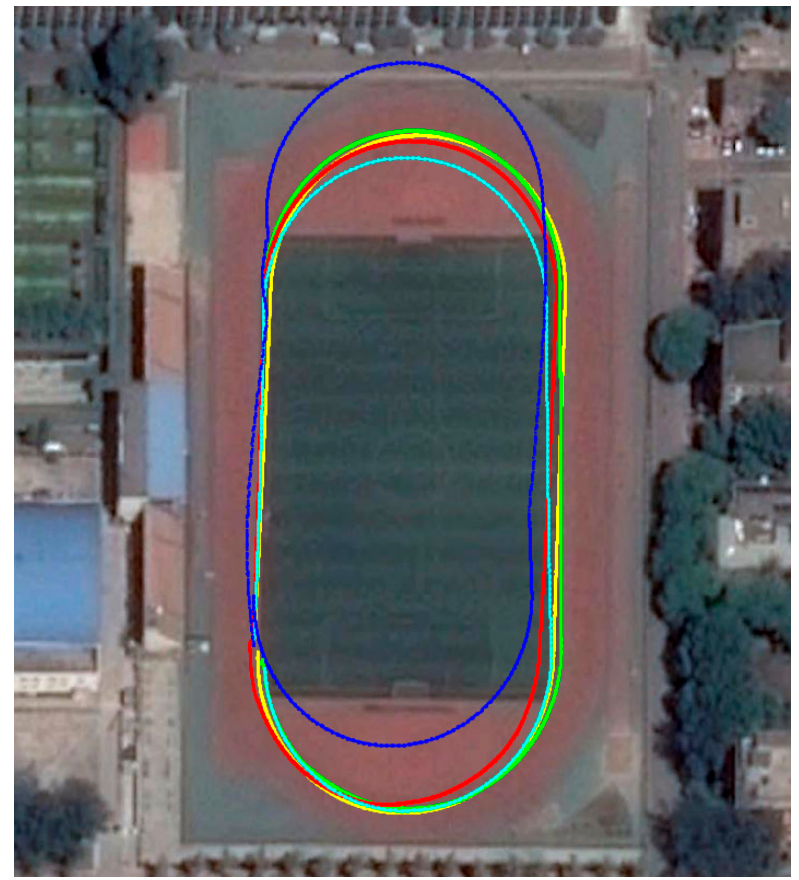
Figure 11. Comparison of the calculated trajectories between the proposed algorithm and algorithm [11].